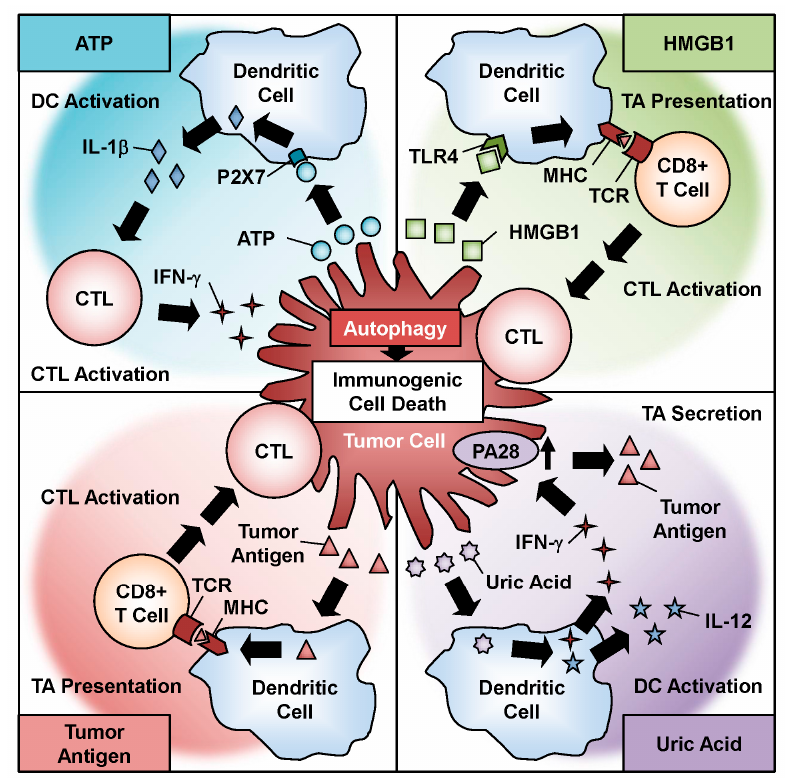
Figure 3. Role of oncolytic adenovirus-induced immunogenic cell death in antitumor immunity. Oncolytic adenovirus-induced autophagy contributes to the induction of immunogenic cell death, which causes the release of danger signal molecules, such as ATP, HMGB1, uric acid, and tumor antigens. The non-histone nuclear factor HMGB1, the most abundant non-histone protein in the nucleus, is another DAMP molecule. HMGB1 is passively released from tumor cells after